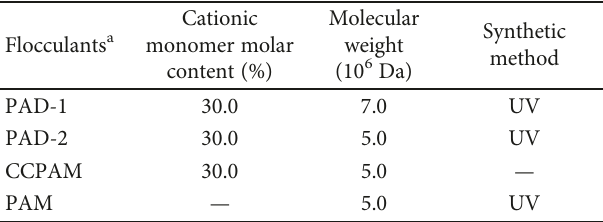
Table 1: The details of fl occulants used in the characterization and fl occulation tests.